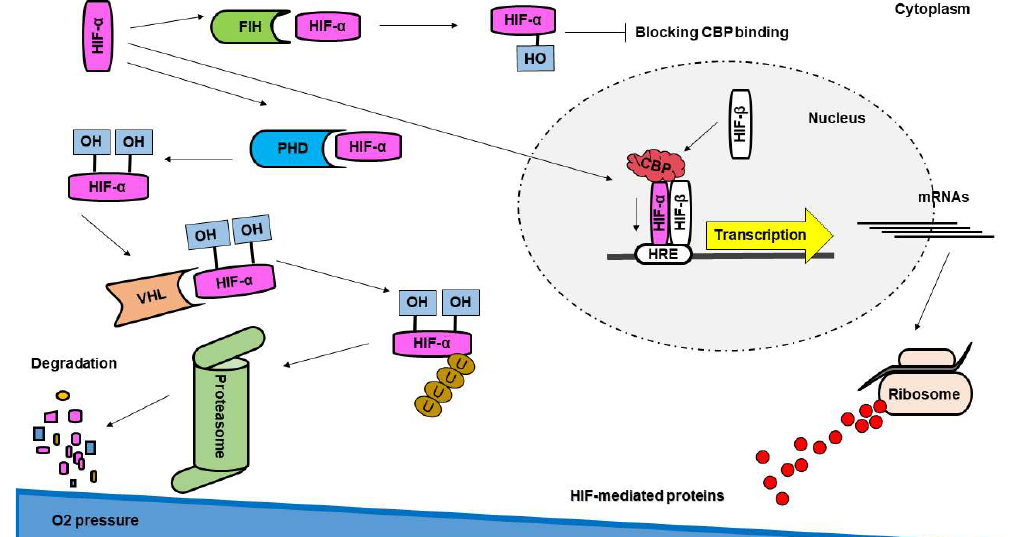
Figure 2. Regulation and function of hypoxia-inducible factors (HIFs). In normal oxygen pressure (normoxia) HIF-α subunits are hydroxylated by prolyl hydroxylase domain (PHD) protein. Hydroxy-HIF-α is recognized by the von Hippel–Lindau E3-ubiquitin ligase complex (VHL), and ubiquitinated HIF-α is subjected to degradation by the proteasome. Simultaneously, HIF-1α is hydroxylated by the factor inhibiting HIF-1 (FIH) protein, resulting in failure to assemble with the transcriptional coactivator CREB-binding protein (CBP). In hypoxia (low oxygen pressure), HIF-α is stabilized, translocates into the nucleus, and dimerizes with HIF-β. Subsequently, HIF heterodimer recognizes the hypoxia-response element (HRE) in the promoter of target genes and assembles with CBP and other coactivators to initiate translation and synthesis of HIF-mediated proteins. OH: hydroxyl; U: ubiquitin.